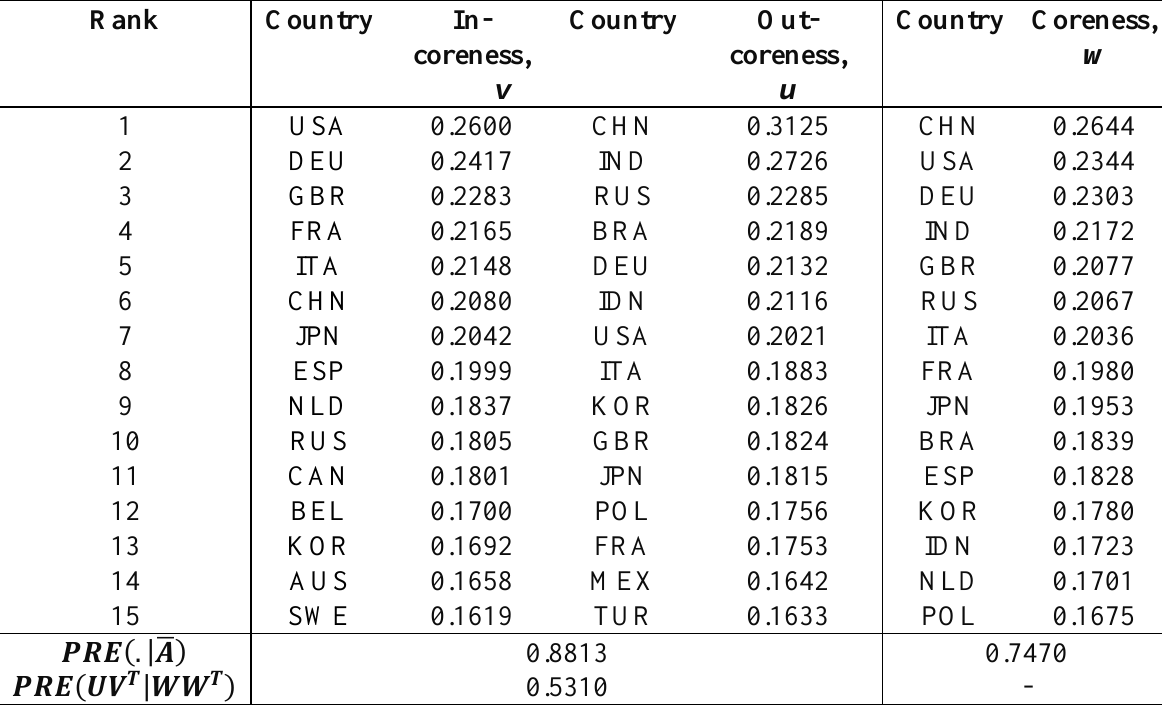
Table 3. Network analysis of the international labor time flows, 2005 Rank Country In- Country Out- Country coreness, coreness, v